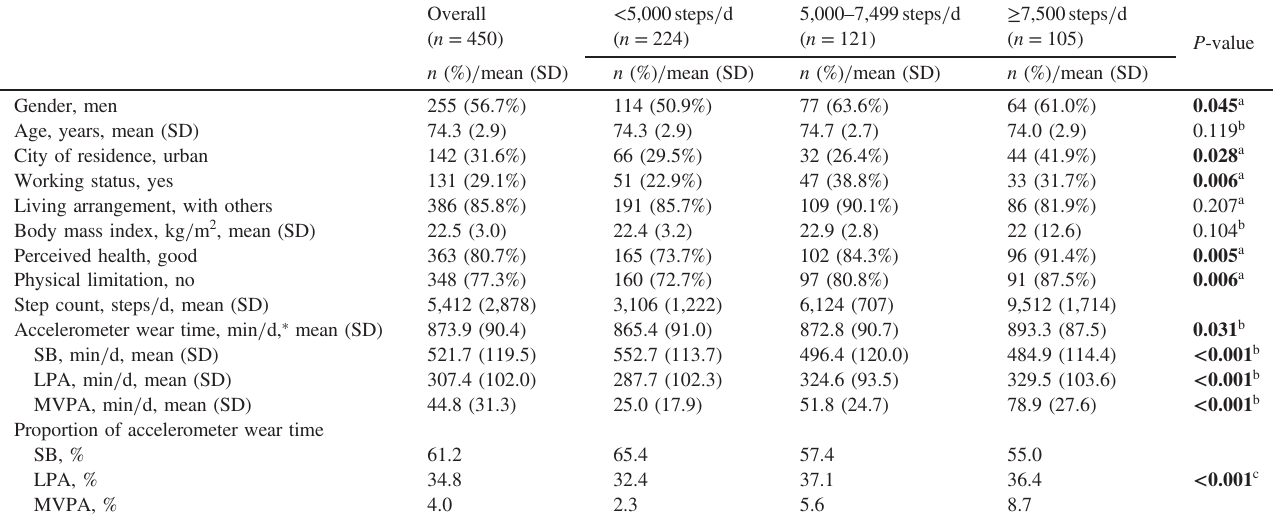
Table 1. Characteristics of study participants and time spent in intensities of physical activity and sedentary behavior by step-based categories